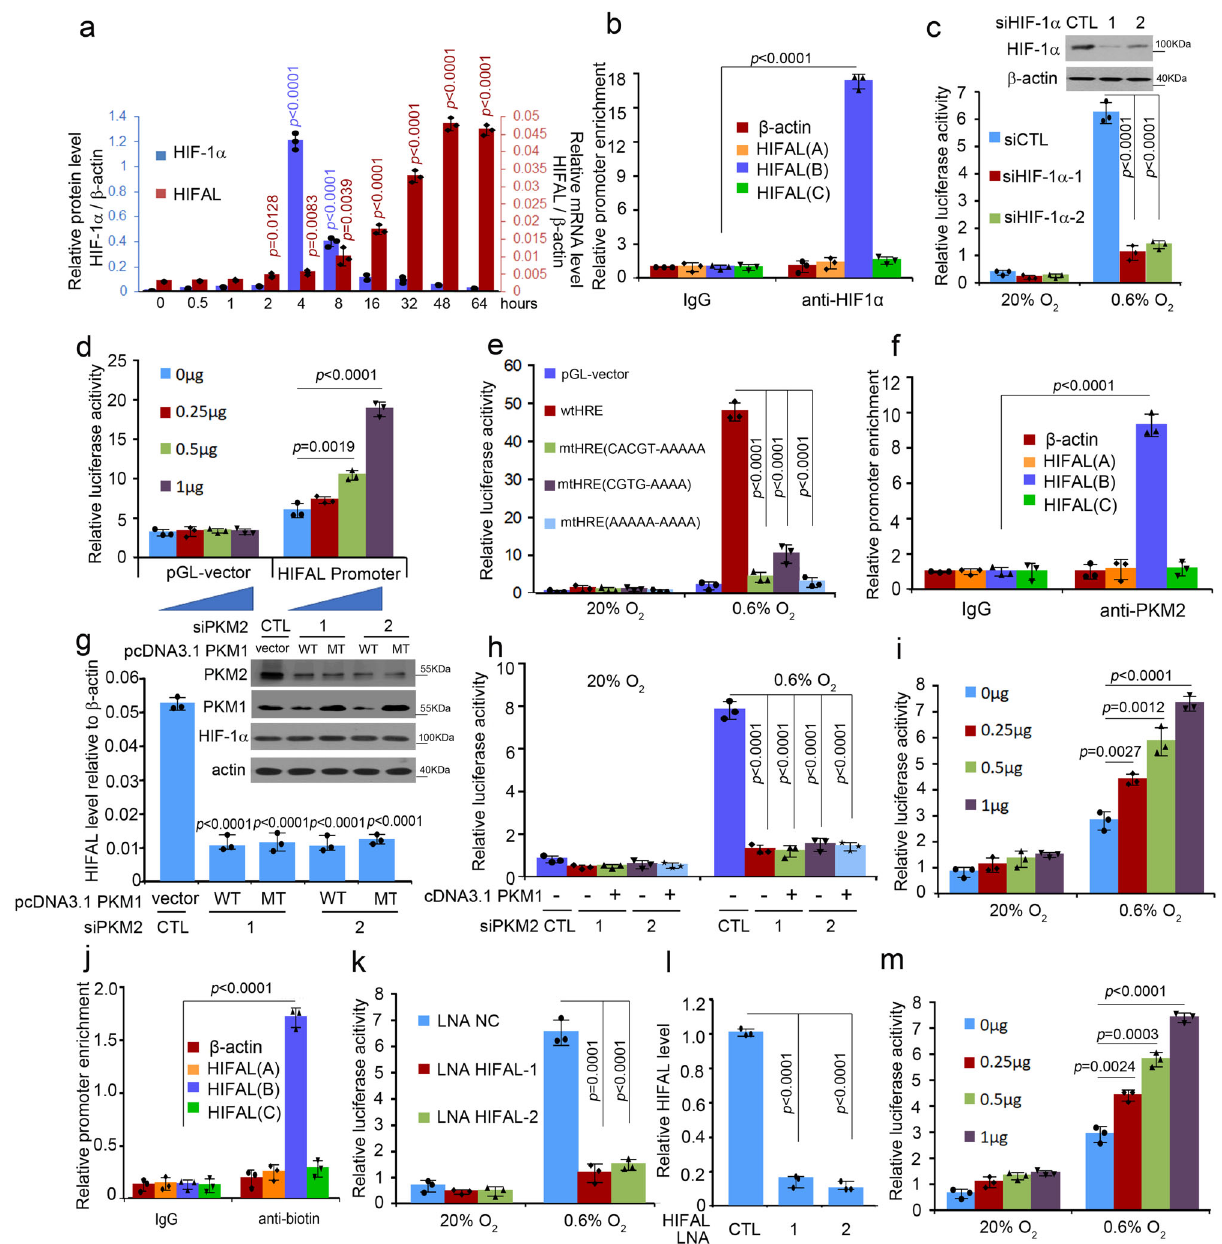
Fig. 5 HIFAL transcription is activated by HIF-1 α transcriptional complex containing HIFAL itself in a feed-forward loop. a HIFAL transcription is not in line with HIF-1 α protein level after hypoxia. b HIF-1 α binds to the HIFAL promoter under hypoxia. MDA-MB-231 cells were cultured under hypoxia for 24